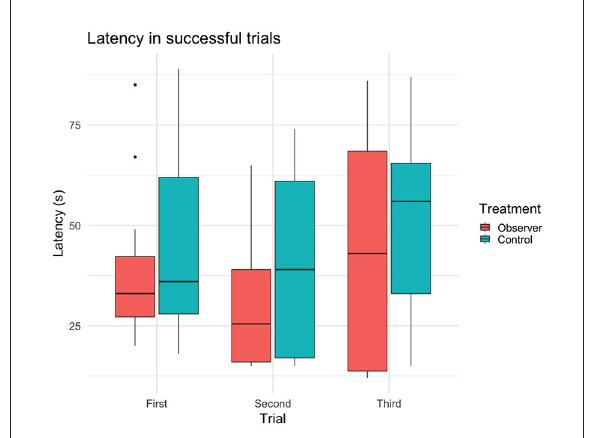
FIGURE4 Latency (sample mean) of reaching the yellow reward bucket and solving task in successful trials ( n = 29 cows, 61